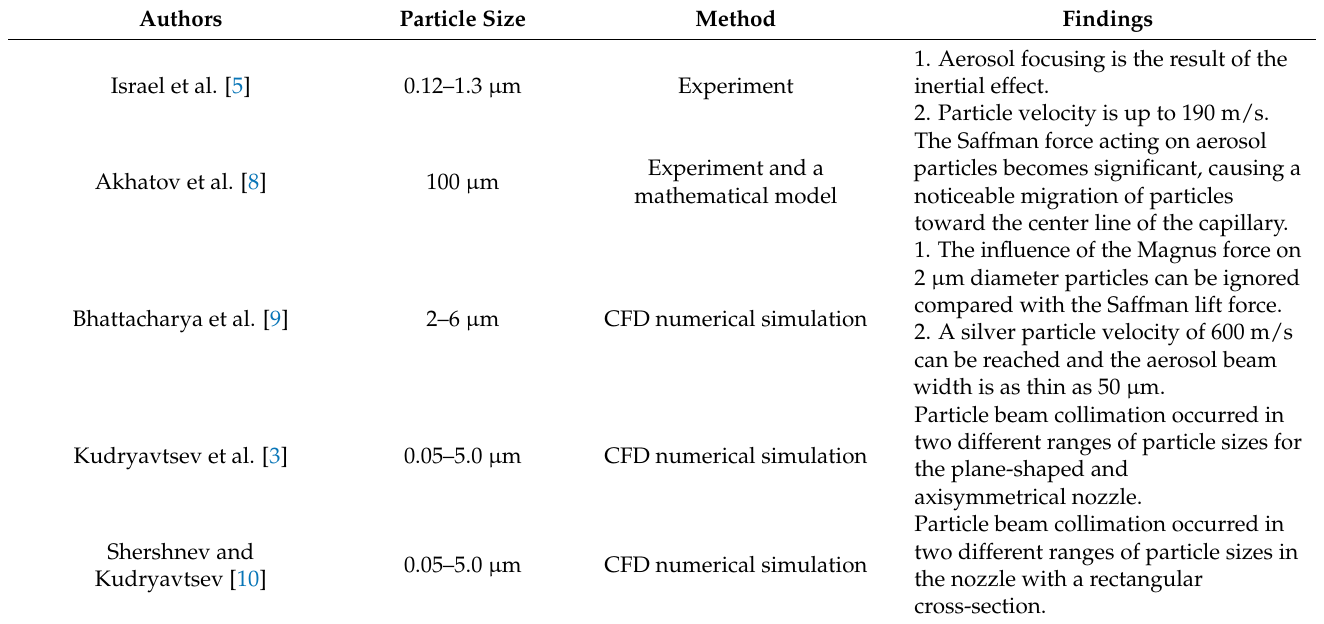
Table 1. The previous studies on aerosol focusing in